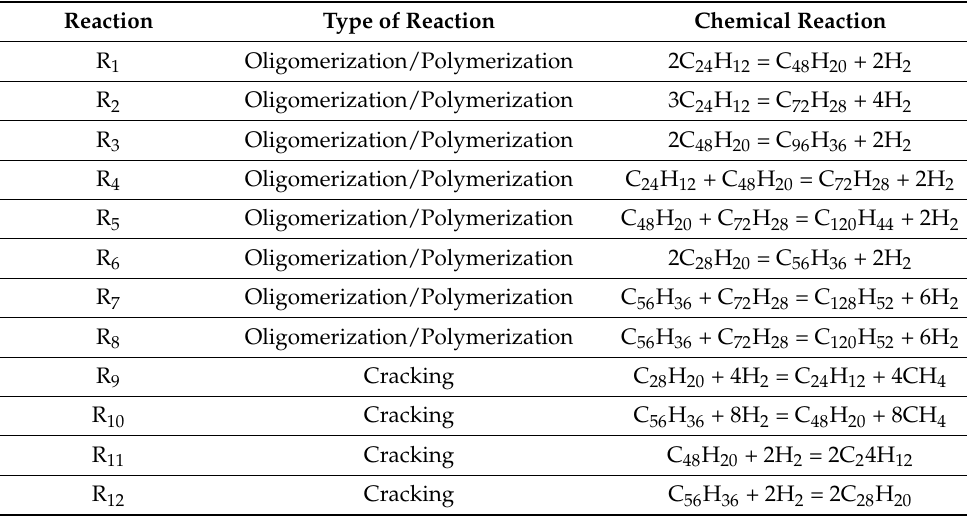
Table 2. Proposed prototype oligomerization reactions in mesophase formation step of carboniza- tion